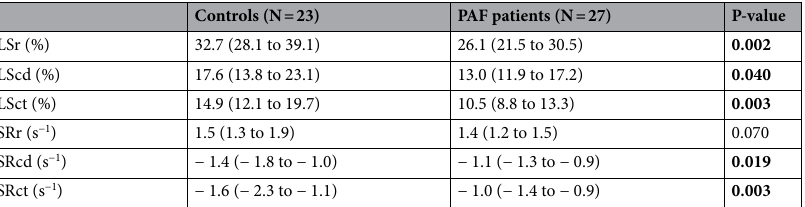
Table 4. Comparison of left atrial strain and strain rate values between PAF patients and controls. Significant values are in bold. Variables are expressed as median (interquartile range). cd conduit, ct contractile, LS longitudinal strain, PAF paroxysmal atrial fibrillation, r reservoir, SR strain rate.